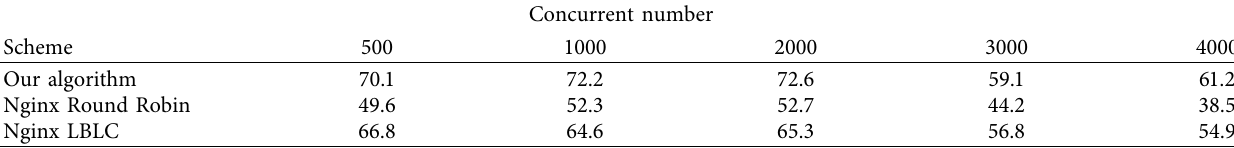
Table 5: Throughput comparison of three front-end server schemes.